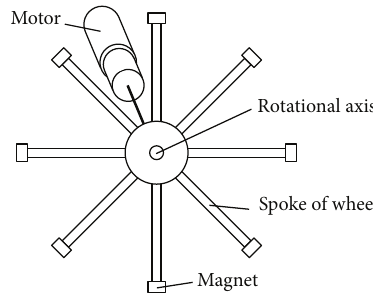
Figure 3: Schematic of rimless wheel and magnets.